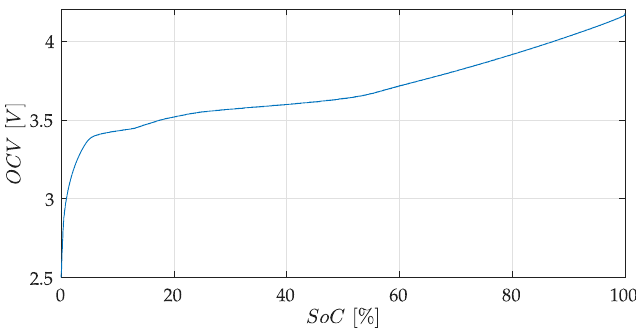
Figure 16. OCV-SoC curve referred to the INR 18650-20R battery